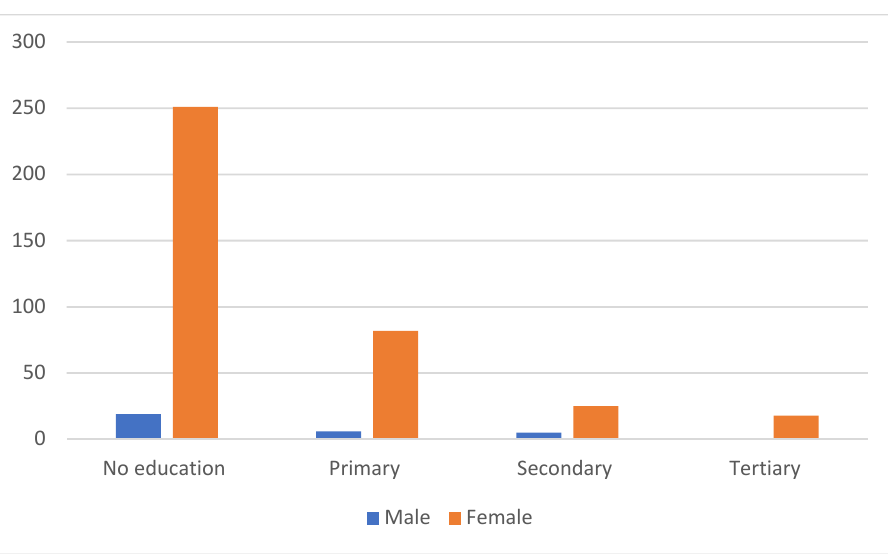
Figure 3. Distribution of respondents’ education level by gender .